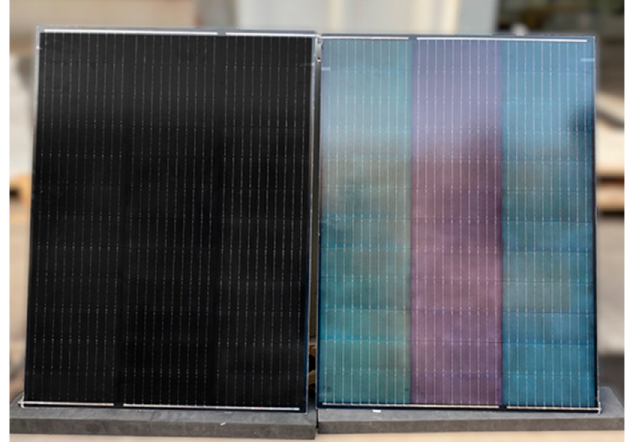
Energies 2023 , 16 , 179 Figure 8. High efficiency coloured BIPVs, reprinted from [34]. Copyright American Chemical Society.